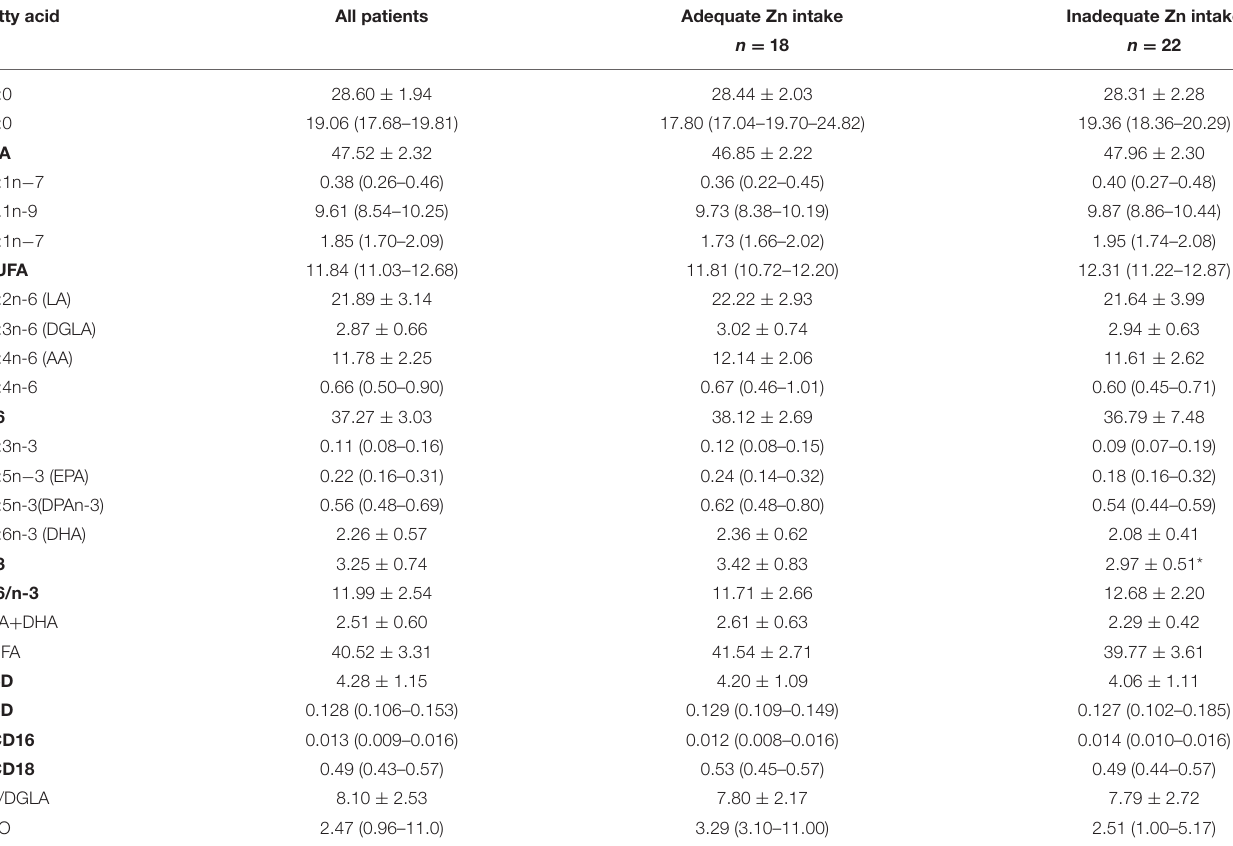
TABLE 3 | Plasma fatty acid status in hemodialysis patients. Fatty acid All